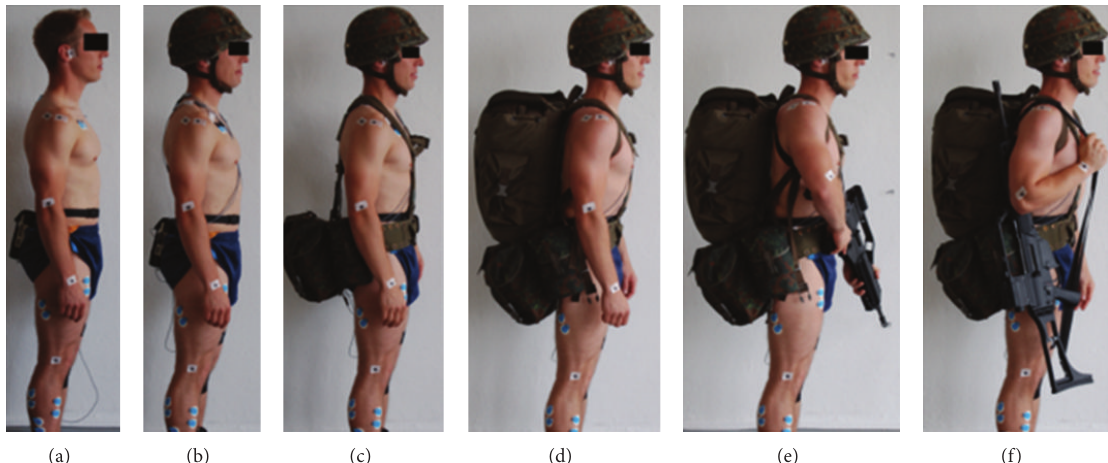
Figure 1: Load conditions: (a) no equipment, (b) helmet, (c) load-carrying equipment, (d) backpack, (e) rifle carried in front of the body, and (f) rifle slung over the shoulder.